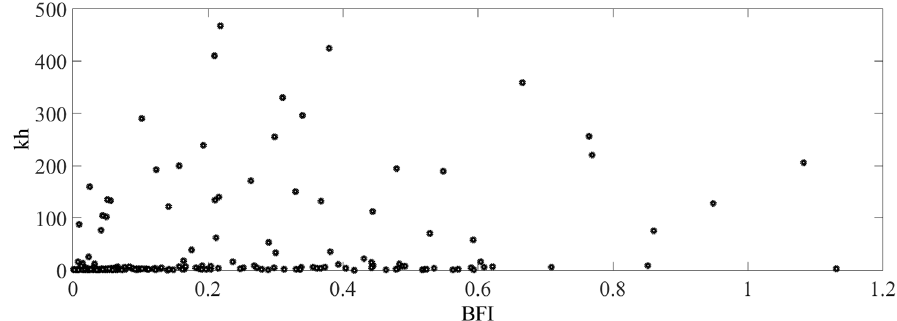
Figure 10. Benjamin–Feir instability (BFI) index versus the parameter kh for deep and shallow events.